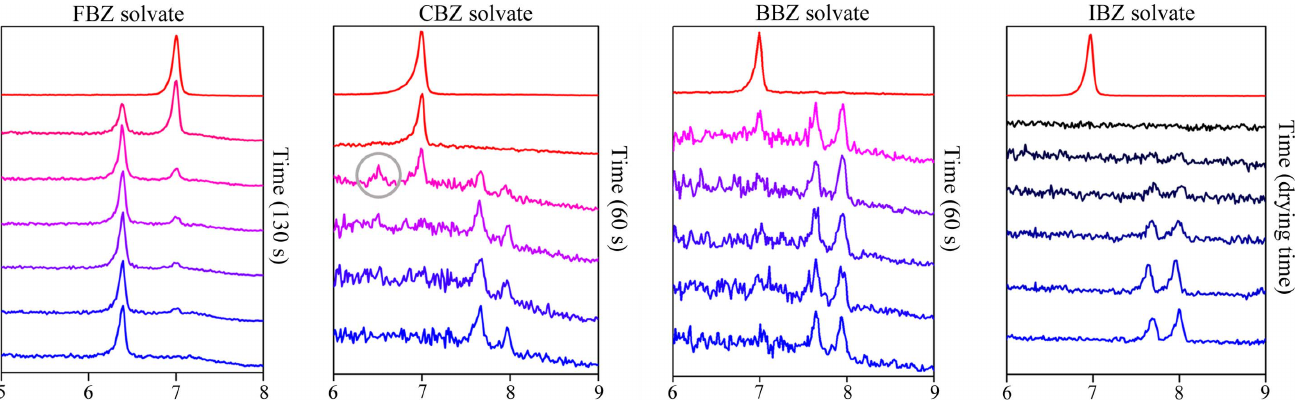
Figure 4 Transformation of ibrutinib form C to all four solvates illustrated by the evolution of diffraction